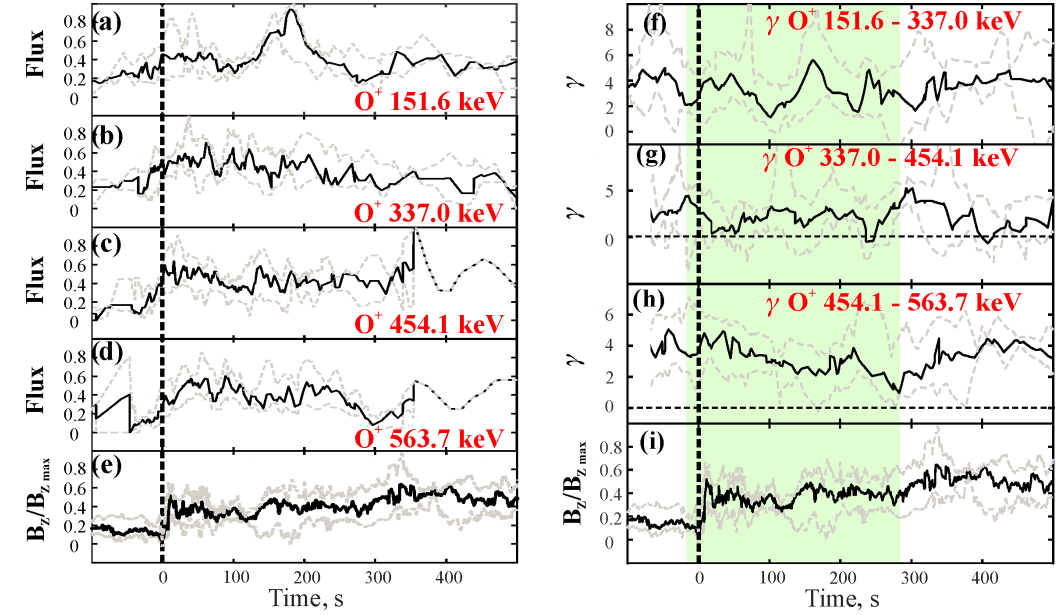
Figure 5. The epoch profiles for O + ions. The format of the figure is similar to the format of Fig. 3.